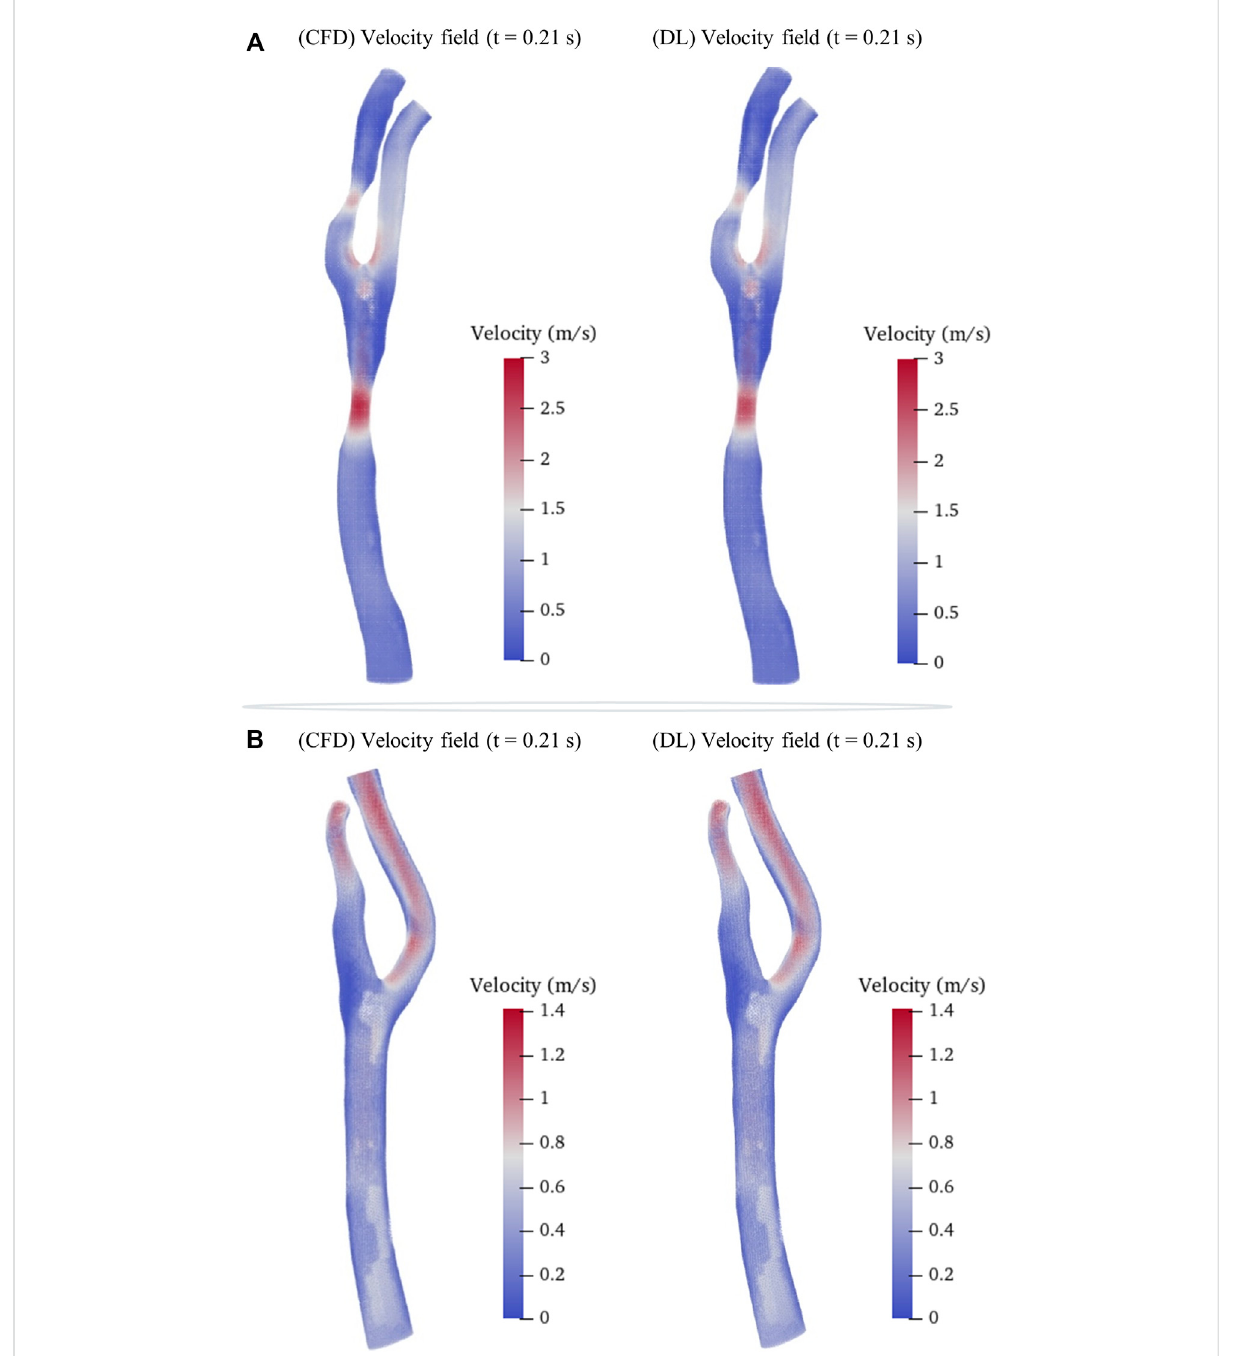
FIGURE 6 Comparison of velocity fi elds between CFD results and DL prediction. (A) . Carotid stenotic artery model; (B) . Carotid artery model without stenosis (cavity changed